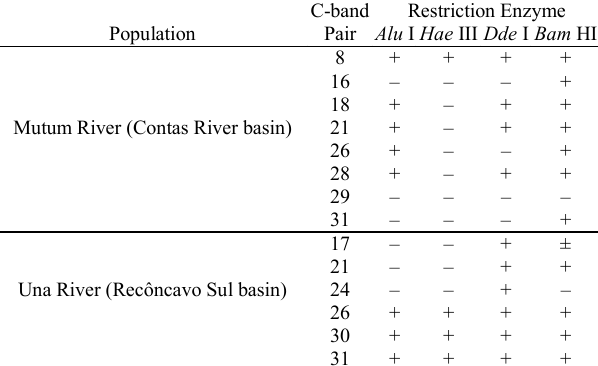
Table 1. Results of enzymatic digestion of C-bands in chromosomal pairs of Hypostomus cf. wuchereri , using the restriction endonucleases Alu I, Hae III, Dde I, and Bam